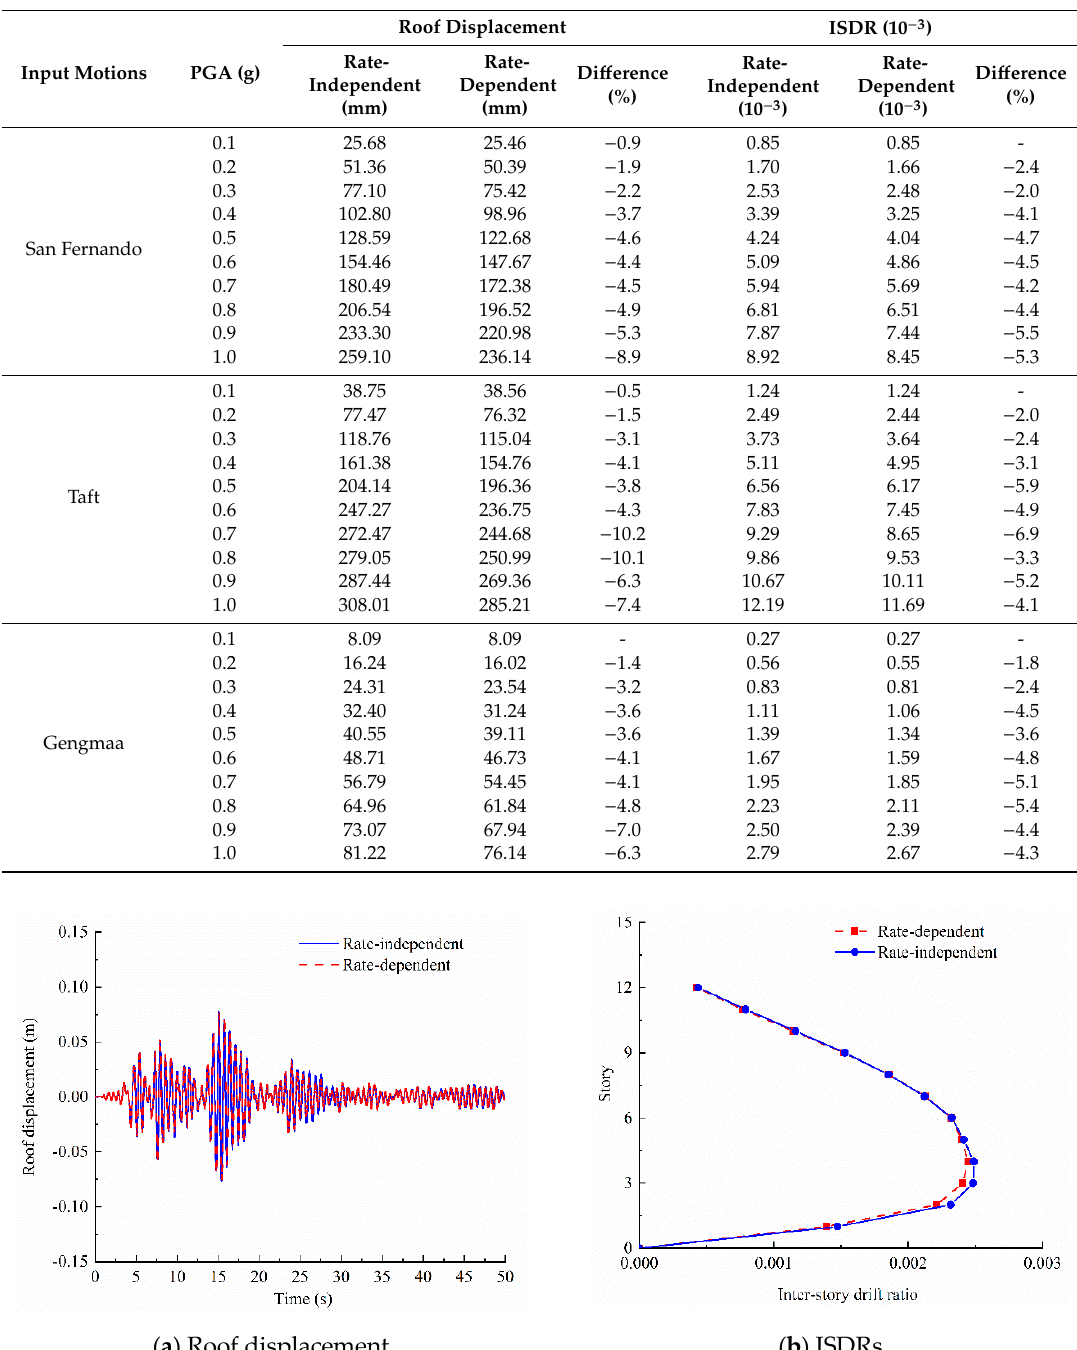
Table 1. The influence of strain rate on a structural seismic response.